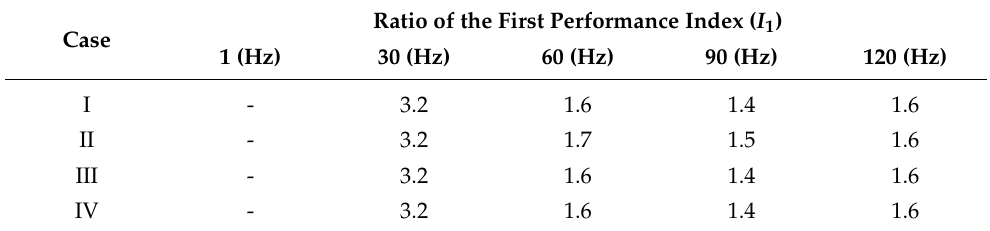
Table 3. Ratio of the first performance index for four vibration isolator cases.